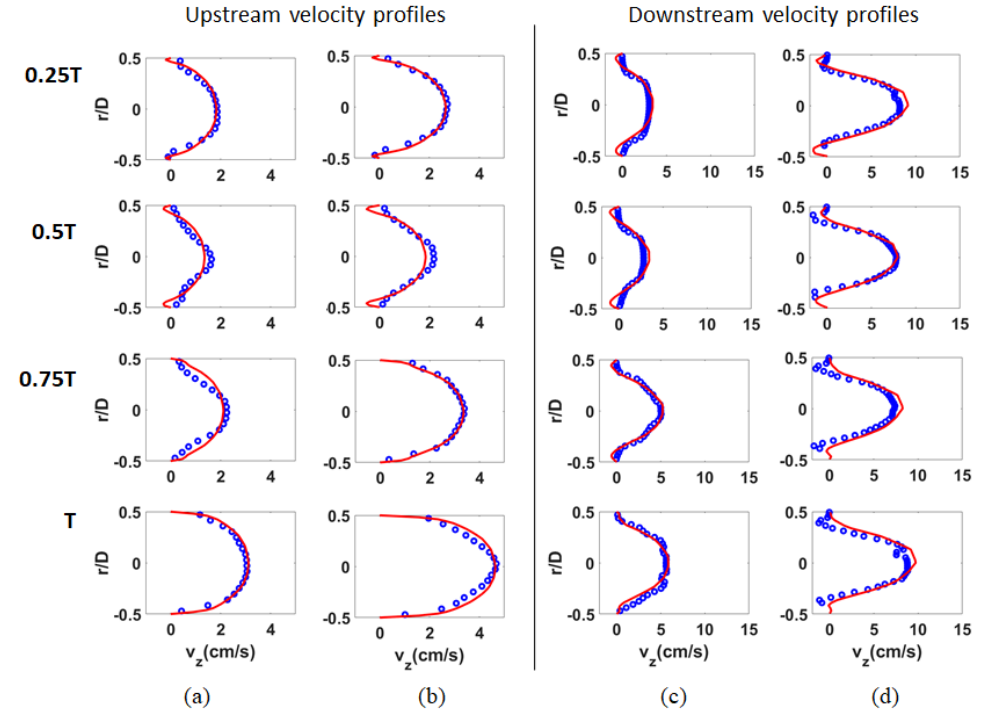
Figure 6: Experimental (blue circles) and numerical (red solid line) velocity profiles at upstream location z = − 0 . 3 D for (a) Re u =820, (b) Re u =1187 and at downstream location z = 0 . 75 D for (c) Re u =820, (d) Re u